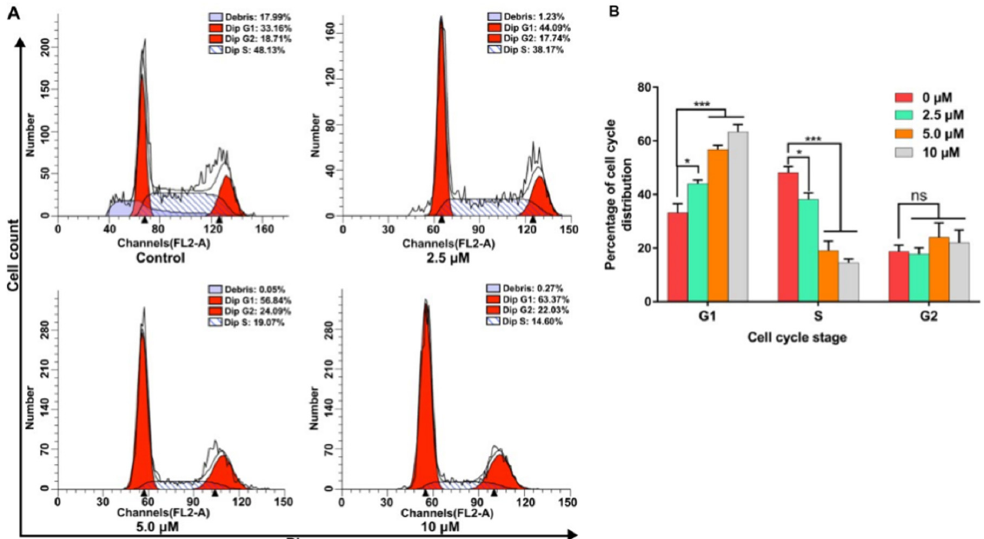
Figure 4. Compound 7a induced G0/G1 phase arrest. ( A ) The representative images of cell cycle distribution after treatment of compound 7a at indicated concentrations. ( B ) The statistical results of cell cycle distribution after treatment of compound 7a . Data are expressed as means ± SD of the percentages of apoptotic cells from three independent experiments. Statistical significance is determined by two-tailed Student t -test: “***” denote p < 0.001, “*” denote p < 0.05 and ns means no significance, respectively (Supplementary Table